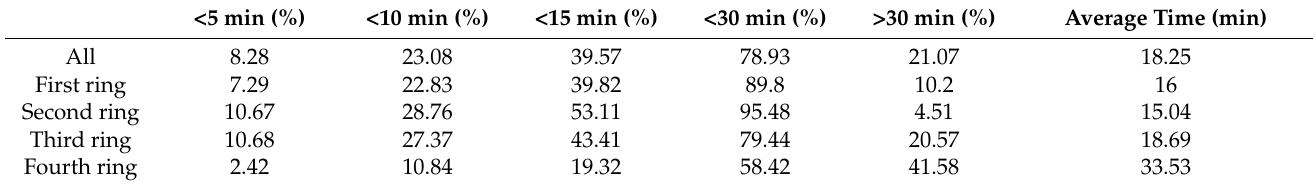
Figure 4. Accessibility measurement of the existing facility configuration (created by the authors). Table 2. The current statistics of healthcare services coverage for each ring